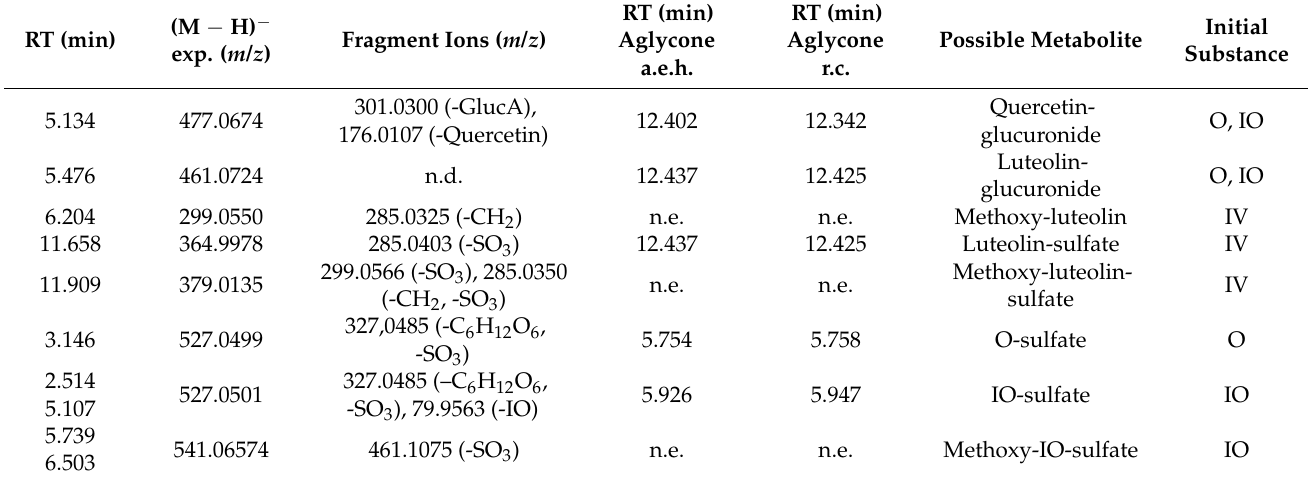
Table 1. Identification of phase II metabolites using UHPLC-DAD-MS/MS fragmentation and comparison of the retention times (RTs) with a reference compound (r.c.) after enzymatic hydrolysis (a.e.h.); n.d.: not detected; n.e.: not examined; exp.: